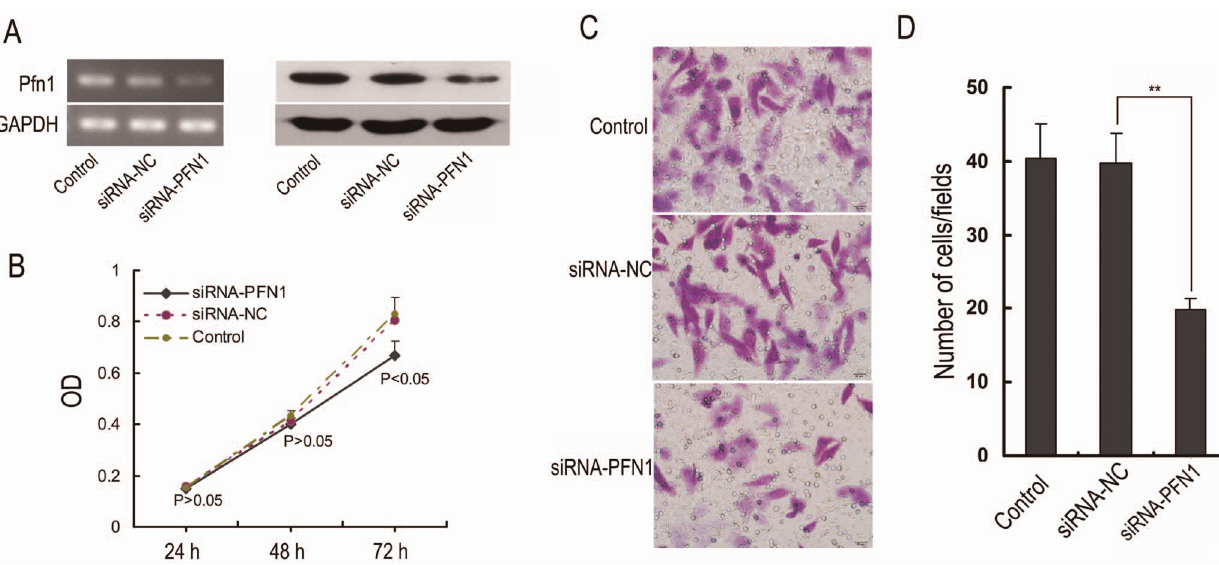
Figure 5. Effects of PFN1 silencing on the proliferation and metastasis of Hep-2 cells. (A) The mRNA (24 h) and protein (48 h) expression of PFN1 after specific siRNA transfection in Hep-2 cells. The levels of mRNA and protein were determined by semiquantitative RT-PCR and Western blotting, respectively. (B) The cell viability of Hep-2 cells harvested 24, 48, and 72 h post-transfection after treatment with siPFN1. The optical density (OD) represents the proliferative characters of the treated cells. (C) The directed migratory capacities of Hep-2 cells after the siPFN1 transfected for 24 h were evaluated using a Transwell migration study. Images of cells on the undersurface of a filter are shown. Bar, 20 m m. (D) The number of cells per field in control and treated cells is shown. Values are the mean 6 SD from three independent experiments. **P ,